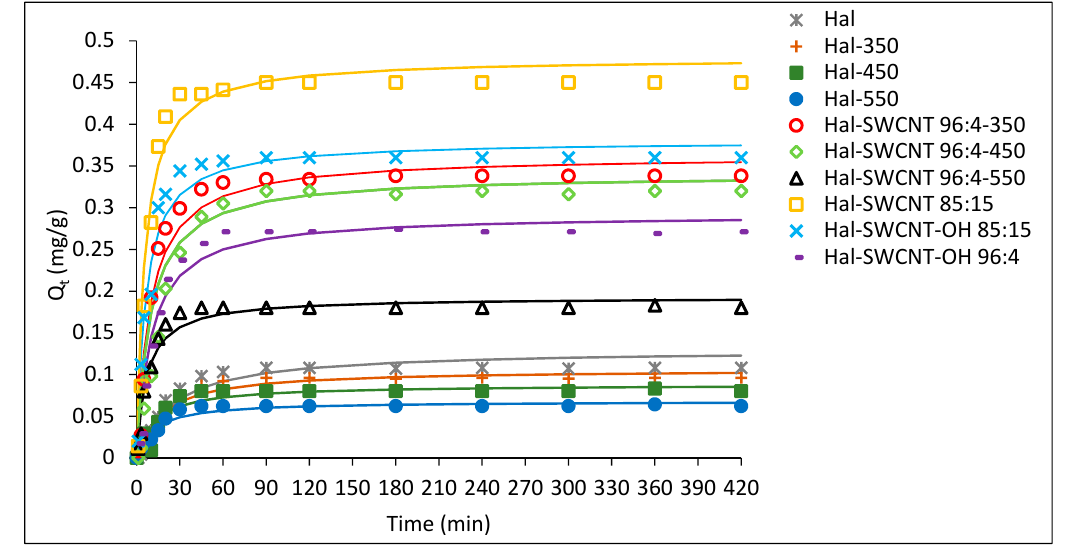
Figure 7. The maximum absorbed amount ( 𝑎 (cid:3013) ) of ANT as a function of BET SSA of Hal-CNT composites. The solid line represents linear fitting.